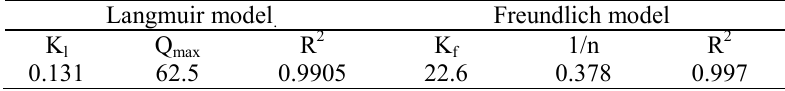
Figure 7. Langmuir adsorption isotherm of U(VI) onto STH (pH=6.5, T=303K).